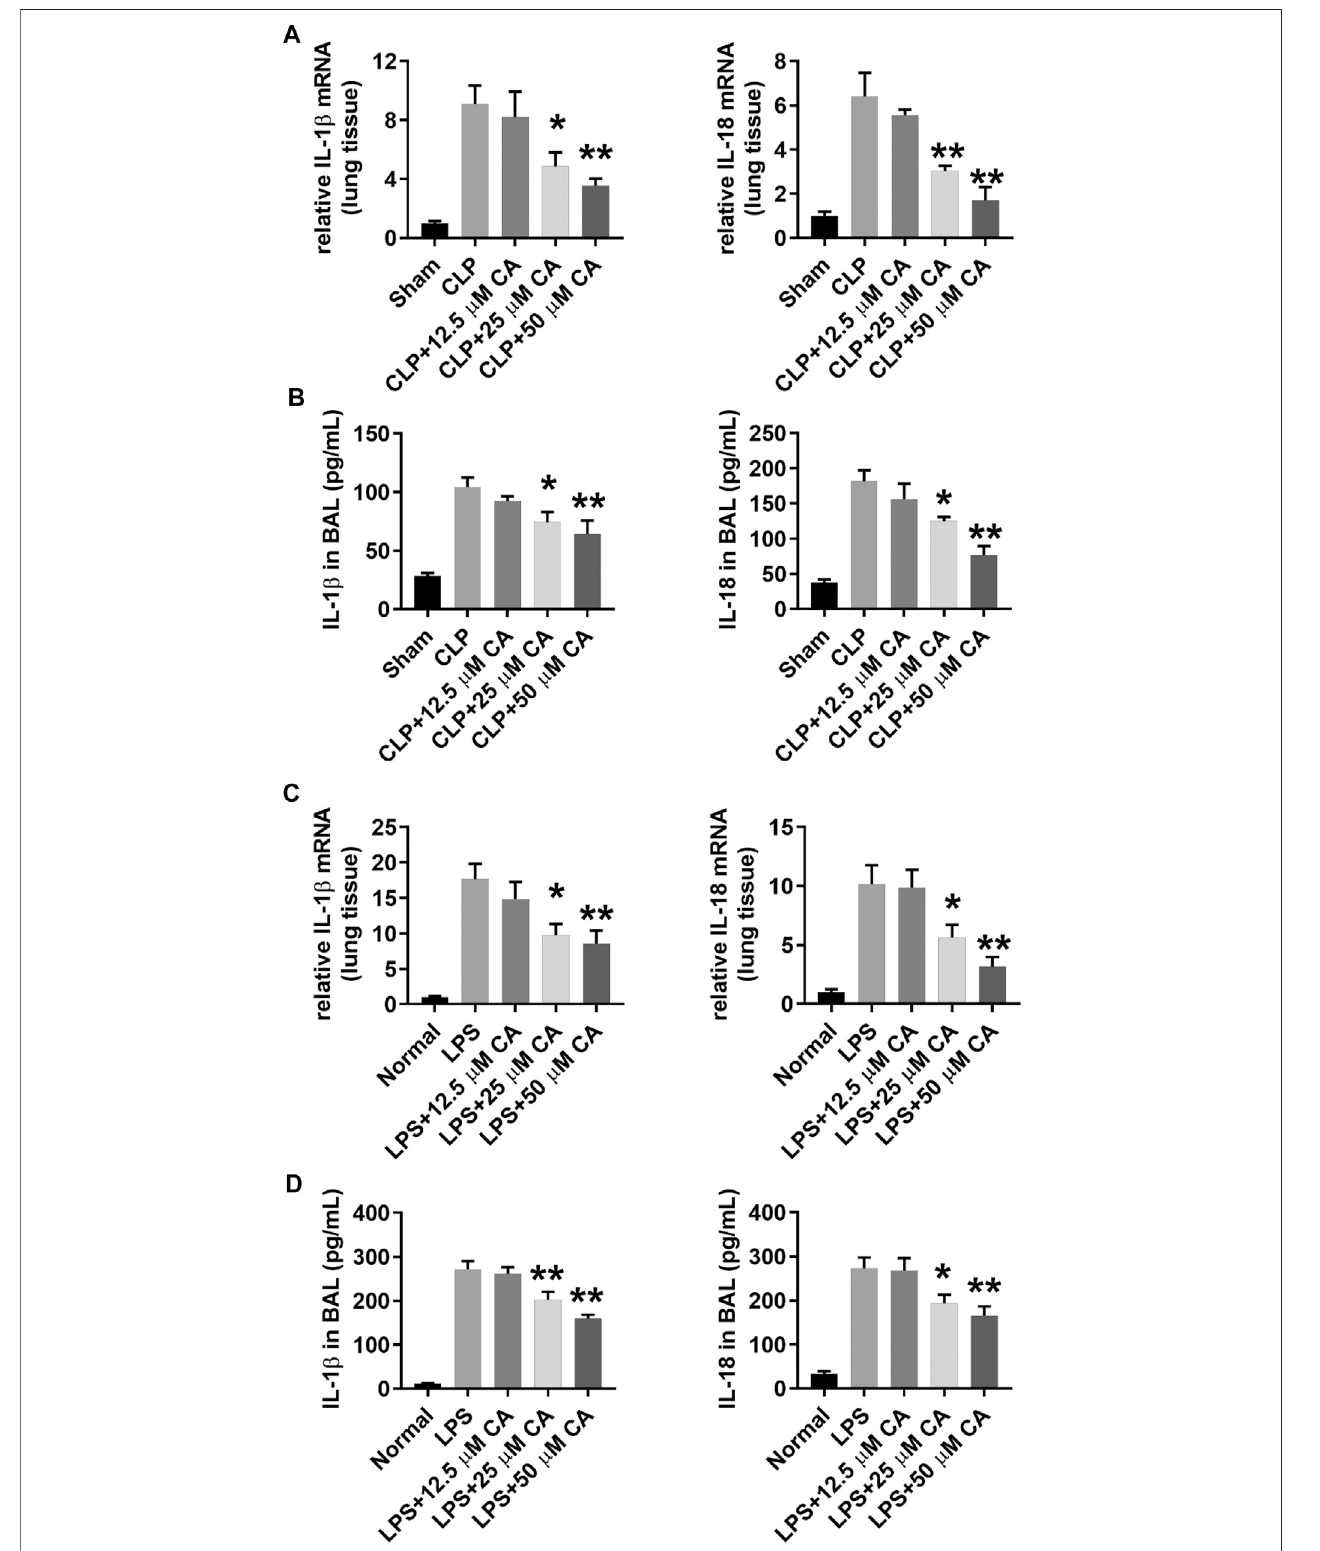
FIGURE 3 | Calycosin reduces IL-1 β and IL-18 mRNA and protein levels in lung tissue and BALF. The ligated or LPS-injected mice were treated with calycosin by gavage at 0 and 6 h. After 12 h, mRNA expression and protein levels in lung tissue and BALF were determined by real-time PCR and ELISA assay (10 mice per group). Data are presented as means ± SEM. * p < 0.05; ** p < 0.01 vs. the CLP or LPS group.